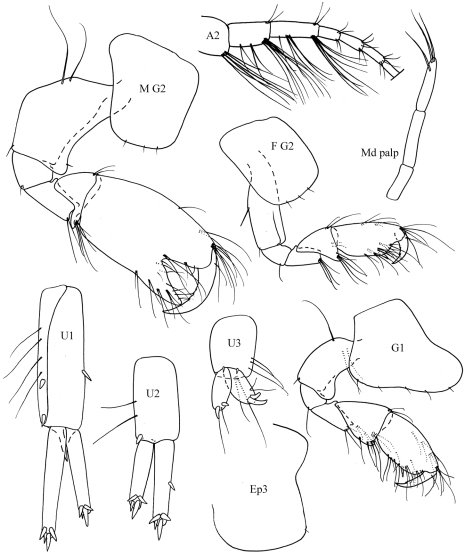

Plumithoe latasp. n., male, female